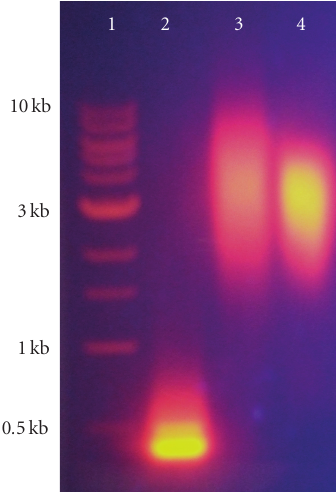
Figure 4: Agarose gel electrophoresis of qdots conjugates (1% agarose gel; Tris-acetate-EDTA bu ff er containing ethidium bromide for DNA visualization; 80 V potential di ff erence). A 1-kb DNA ladder (Lane 1; New England Biolabs, Ipswich, Mass, USA), with DNA fragments ranging from 0.5–10 kilobases (kb) as indicated, was utilized to illustrate relative electrophoretic mobility of the qdot conjugates. Unconjugated AMP-coated qdots (Lane 2) have an increased mobility by comparison with both muscimol-conjugated qdots (Lane 3) and qdots conjugated with methoxy terminated PEG2000 (Lane 4), indicating successful functionalization of the qdot surface.